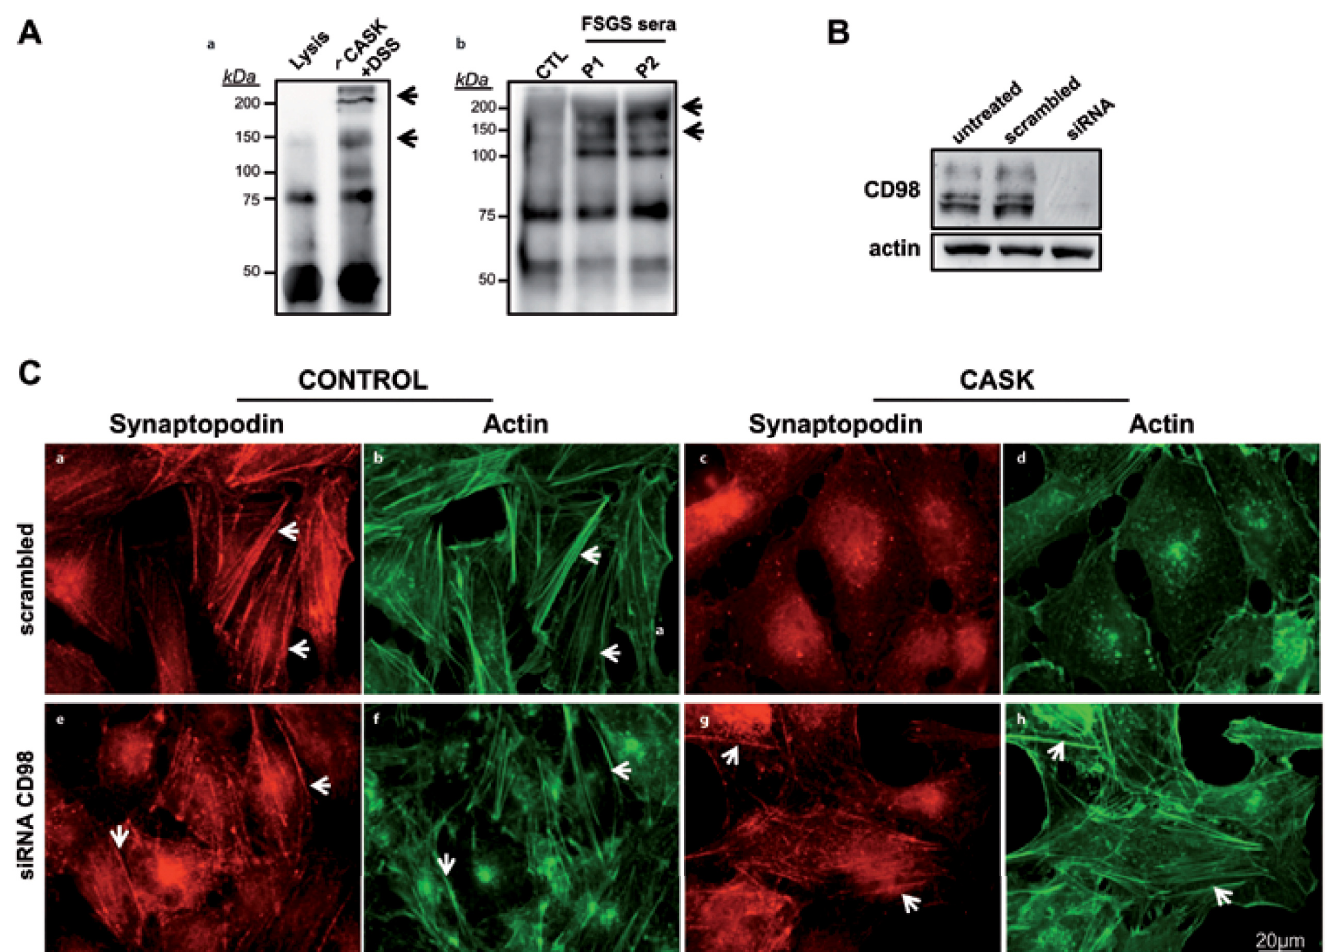
Fig 5. Interaction of CASK with CD98 on the surface of podocytes. A) Coimmunoprecipitation of CASK and CD98 on the membranes of podocytes. Cells were incubated with either recombinant myc-tagged CASK (a) or human sera (b) (one healthy control and two rFSGS patients, see Materials and Methods). Immunoprecipitation with anti-myc (for rCASK, 8% PAGE) or anti-CASK (sera, 10% PAGE), followed by Western blotting with anti-CD98, allowed us to identify a single ~75-kDa band that corresponded to CD98. After crosslinking using DSS, other heavier proteins appeared as different bands, suggesting interactions between CASK and CD98. B) Knock-down of CD98 in podocytes by siRNA. Transfection of a set of siRNA oligonucleotides abrogated the expression of CD98. C) siRNA inhibition of CD98 (e,f,g,h) avoided the alterations (c,d) induced by CASK in podocytes. Fibrillar distribution of actin and synaptopodin ( white arrows ) was maintained after the abrogation of CD98 (g,h) by siRNA even in the presence of CASK.